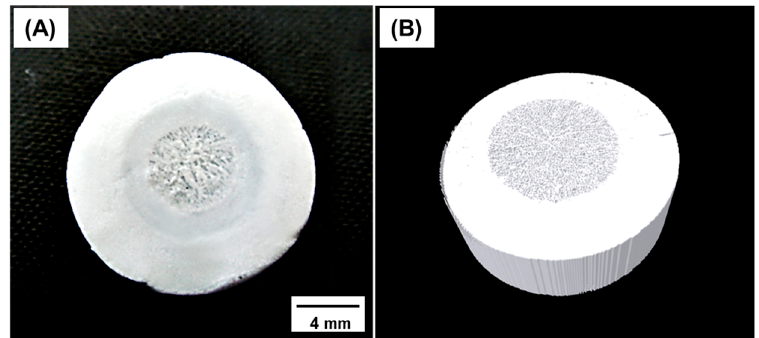
Figure 6. ( A ) Optical and ( B ) reconstructed micro-CT images of a porous hydroxyapatite (HA) scaffold with a bone-like structure and inner and outer initial HA contents of 15 and 40 vol %, respectively.